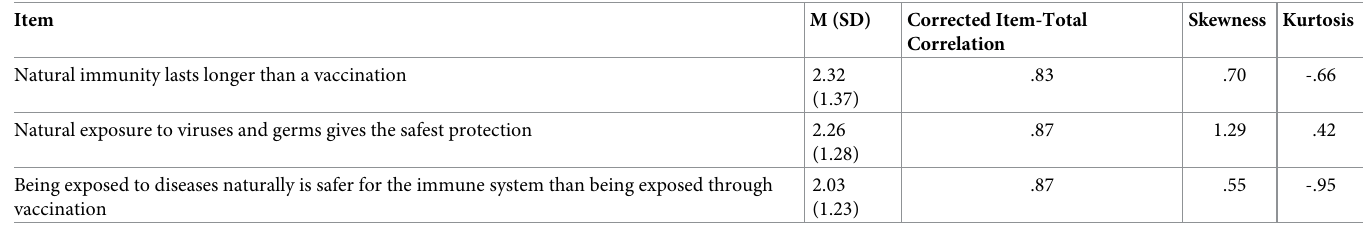
Table 2. Descriptive statistics for the natural immunity beliefs scale. Item